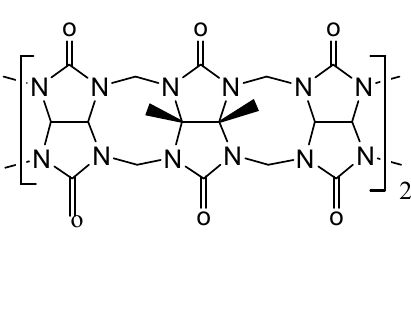
Figure 1 . Structure of